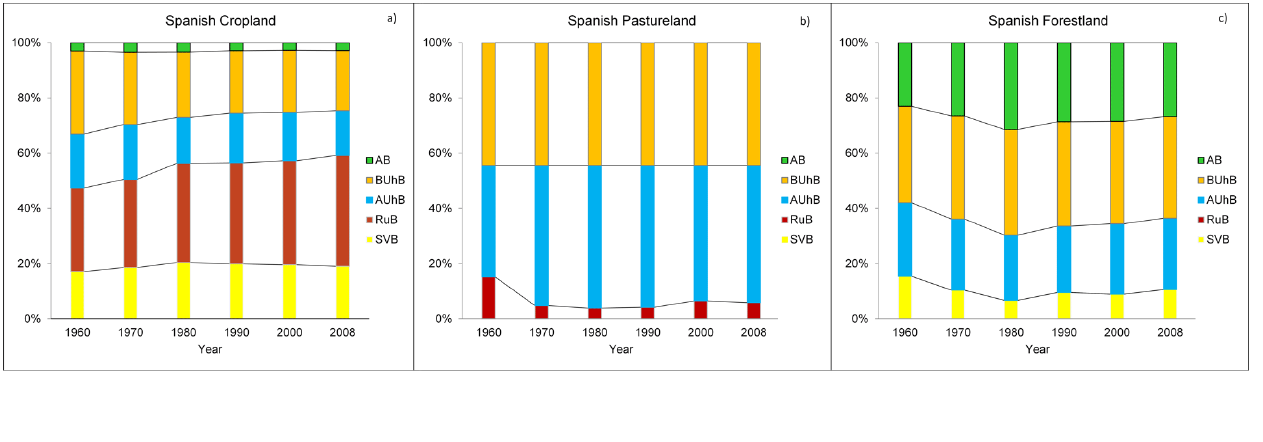
Fig. 2 . Evolution of actual net primary production (in PJ) by its use in relative terms in Spanish cropland (a), Spanish pastureland (b), and Spanish forestland (c). AB, accumulated biomass; AUhB, aboveground unharvested biomass; BUhB, belowground unharvested biomass; RuB, reused biomass; SVB, socialized vegetable